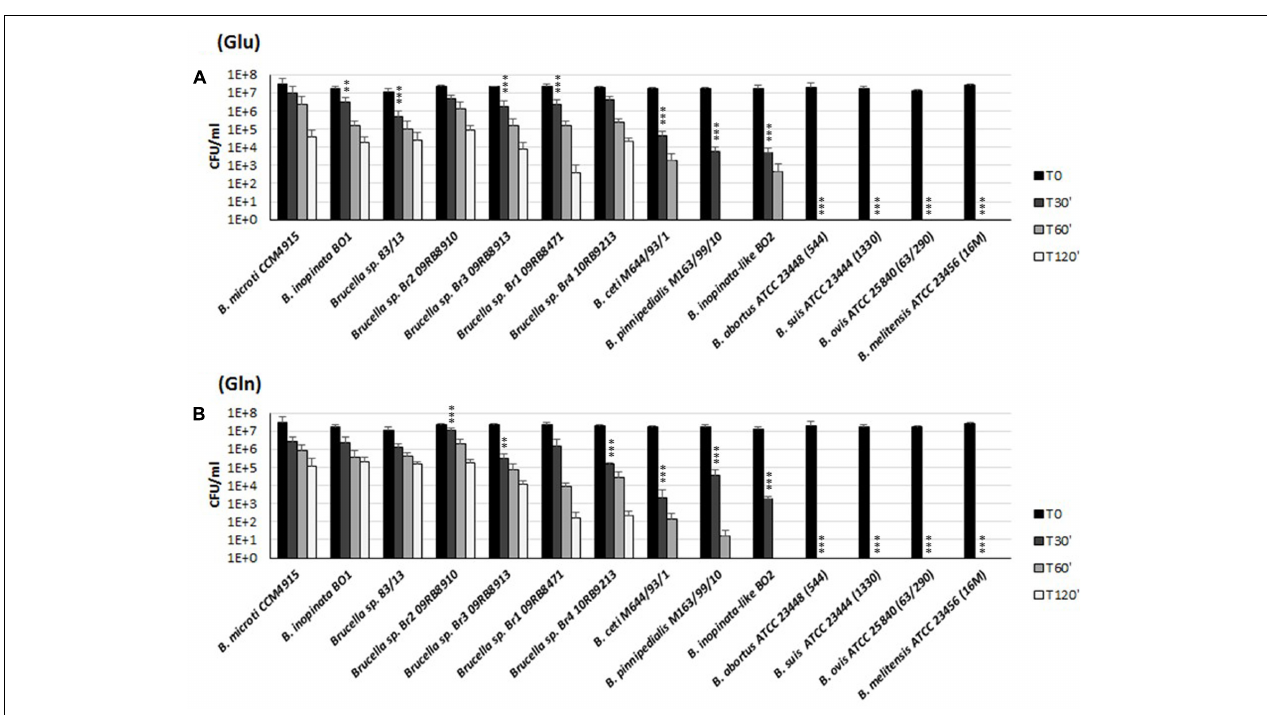
FIGURE 6 | Survival of representative strains and species of Brucella during extreme acid exposure. Bacteria from a stationary phase cultures in TS at pH 7 were harvested and incubated in modified GMM at pH 2.5, supplemented with 3 mM of Glu (A) or Gln (B) . Residual viability following the acid shock was expressed as CFU/ml on a log10-scale at each time-point (T30, T60, and T120 min) and compared to unchallenged bacteria present at time T0 (GMM, pH 7.0). No viable bacteria were detected at the same time-points in the absence of Glu or Gln (data not shown). The data represent the mean (SD) of three independent experiments.